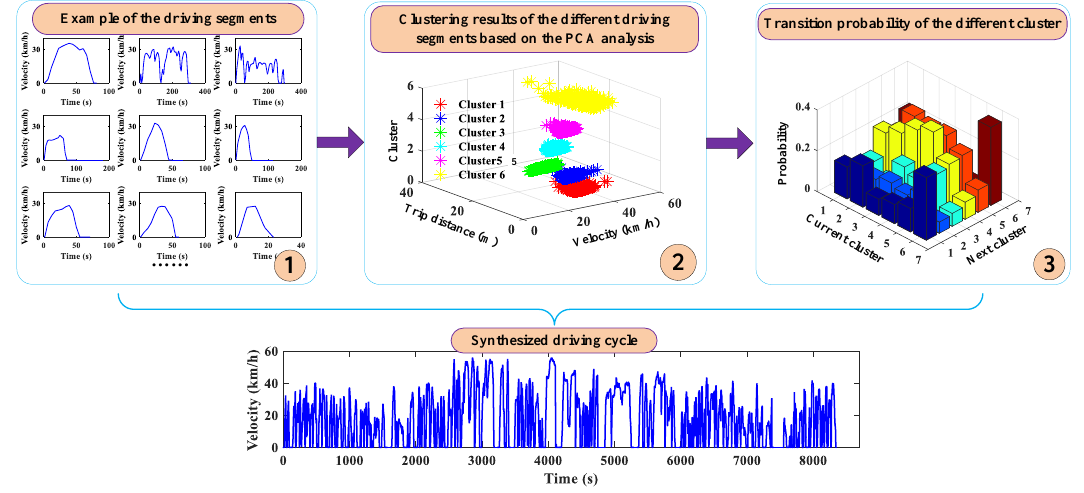
Figure 3. Main process of the driving cycle synthesis.